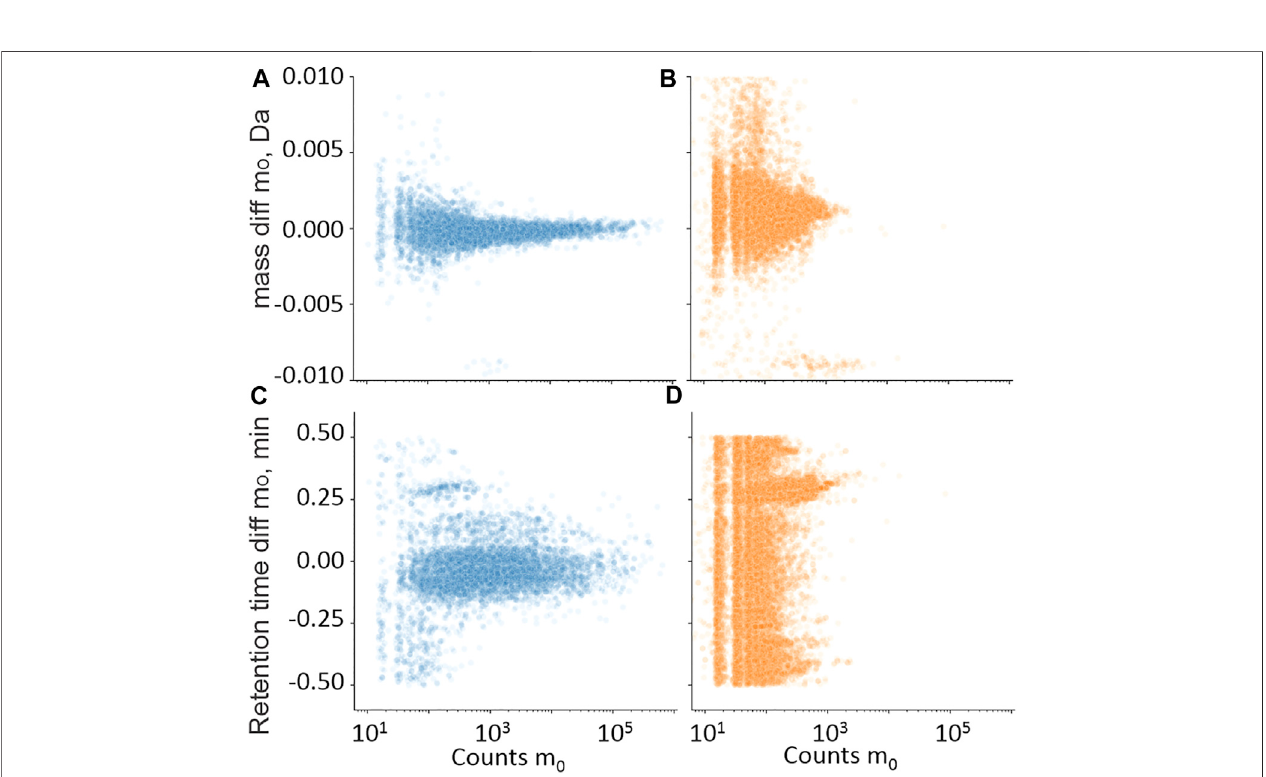
(cid:129) Hits from samples with negative quantitative results (B,D) .